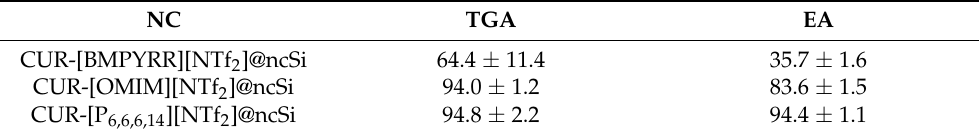
Table 2. Amount of IL (%, w / w ) incorporated into NCs determined by TGA and by